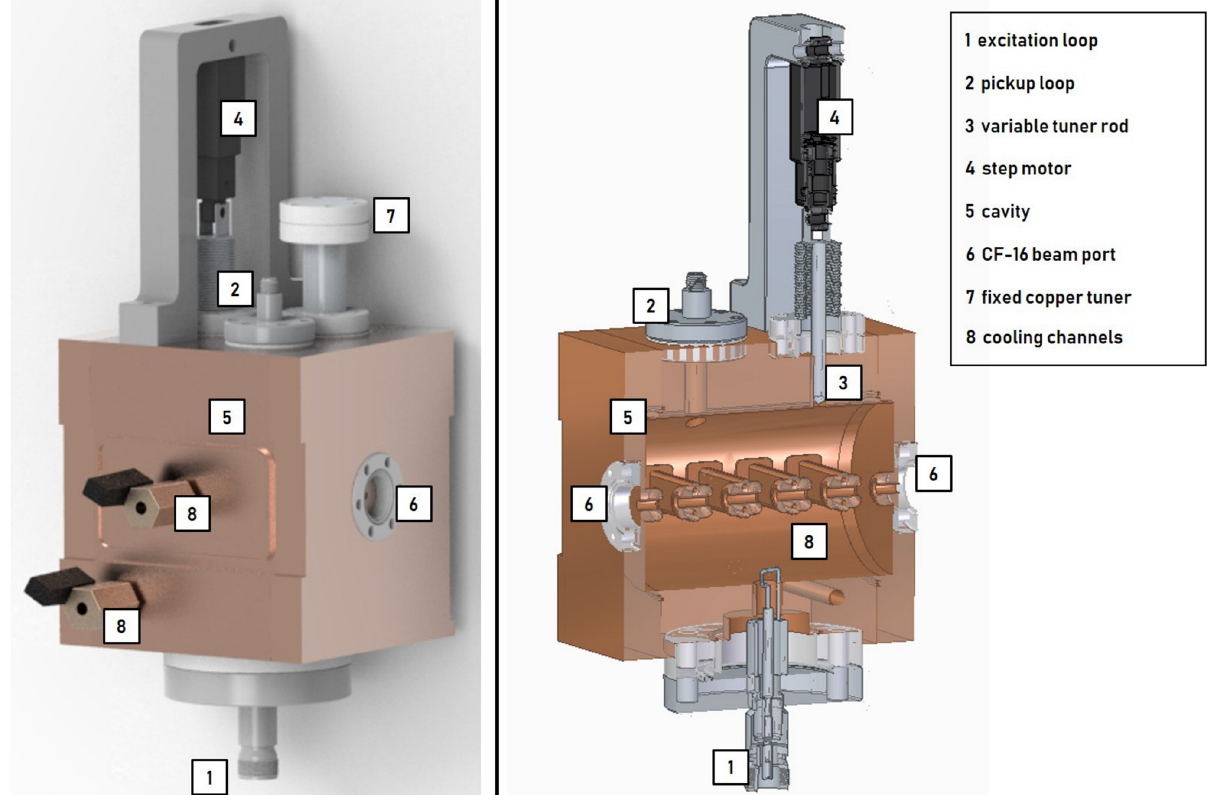
Fig 7. 5-gap buncher unit. Connection to the beam pipe via CF-16 flanges. CF-16 flanges also provide access to the cavity for pickup loop, variable tuner and fixed copper tuner. The excitation loop is mounted on a CF-63 flange.